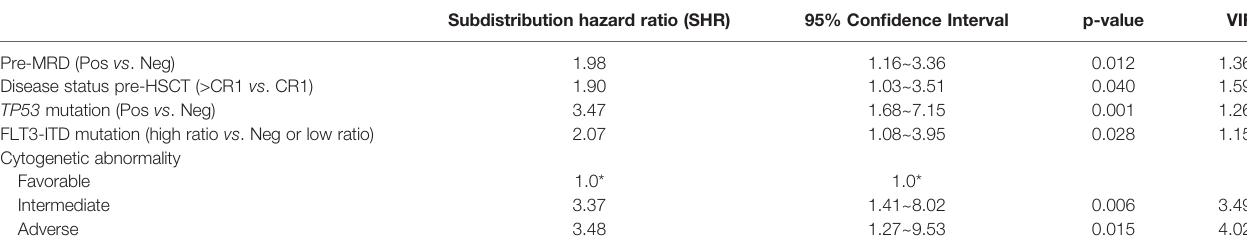
TABLE 2 | Multivariable analysis of factors associated with CIR of the 320-patient primary